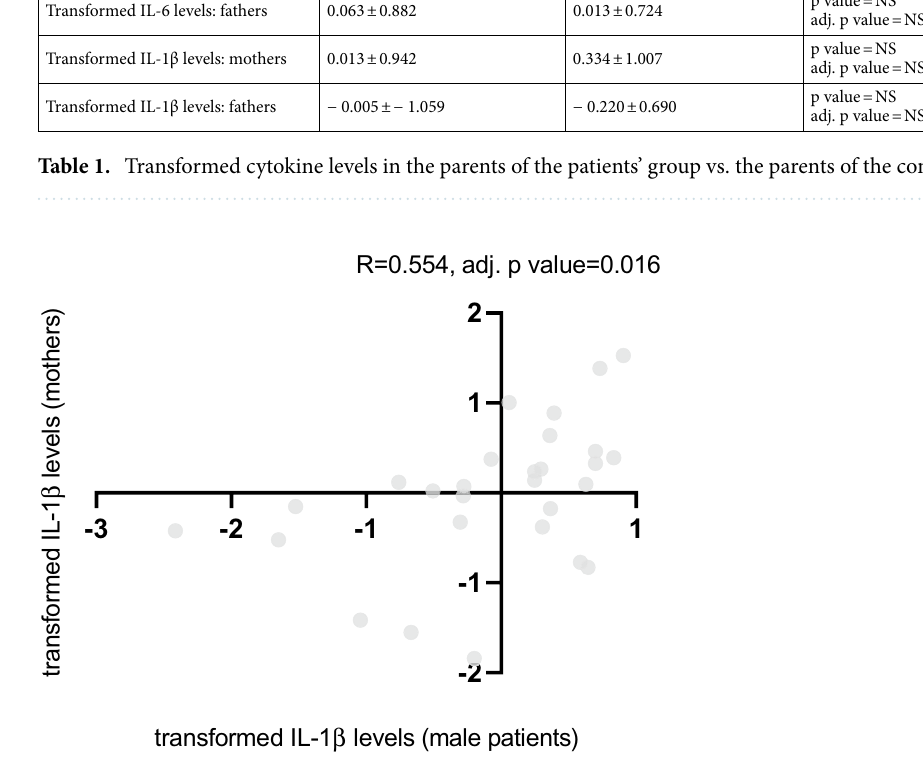
Figure 3. Correlation in transformed IL-1β levels between mothers and their depressed/anxious sons. A positive correlation was found between IL-1β levels in male patients and their mothers (Spearman correlation: R = 0.554, p value = 0.002, adj. p value =